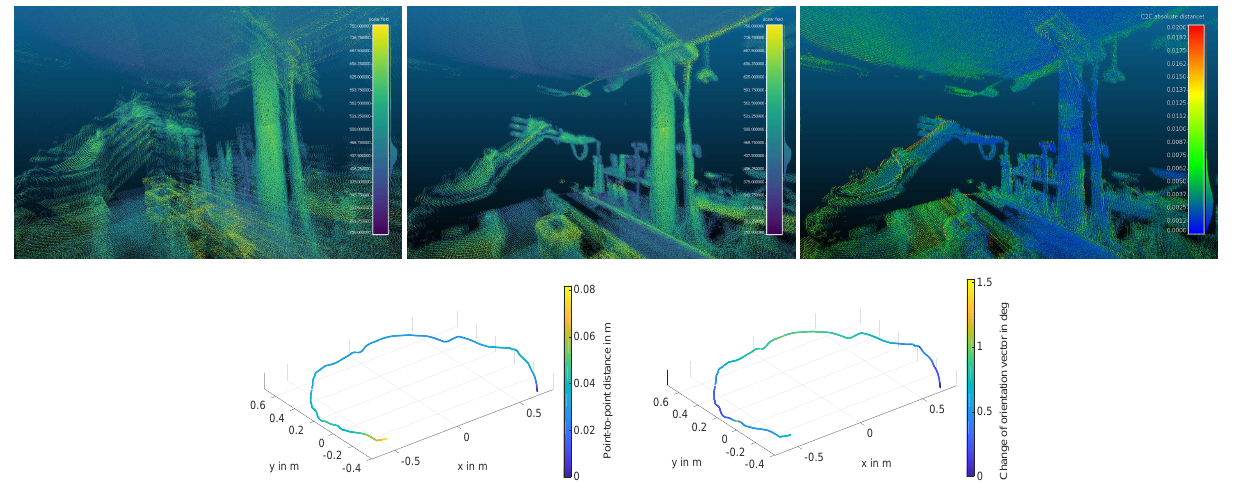
Figure 7. 3D point cloud of the laboratory. Left: Recorded data. Middle: Corrected point cloud used as reference. Right: Error between recorded and corrected point clouds.